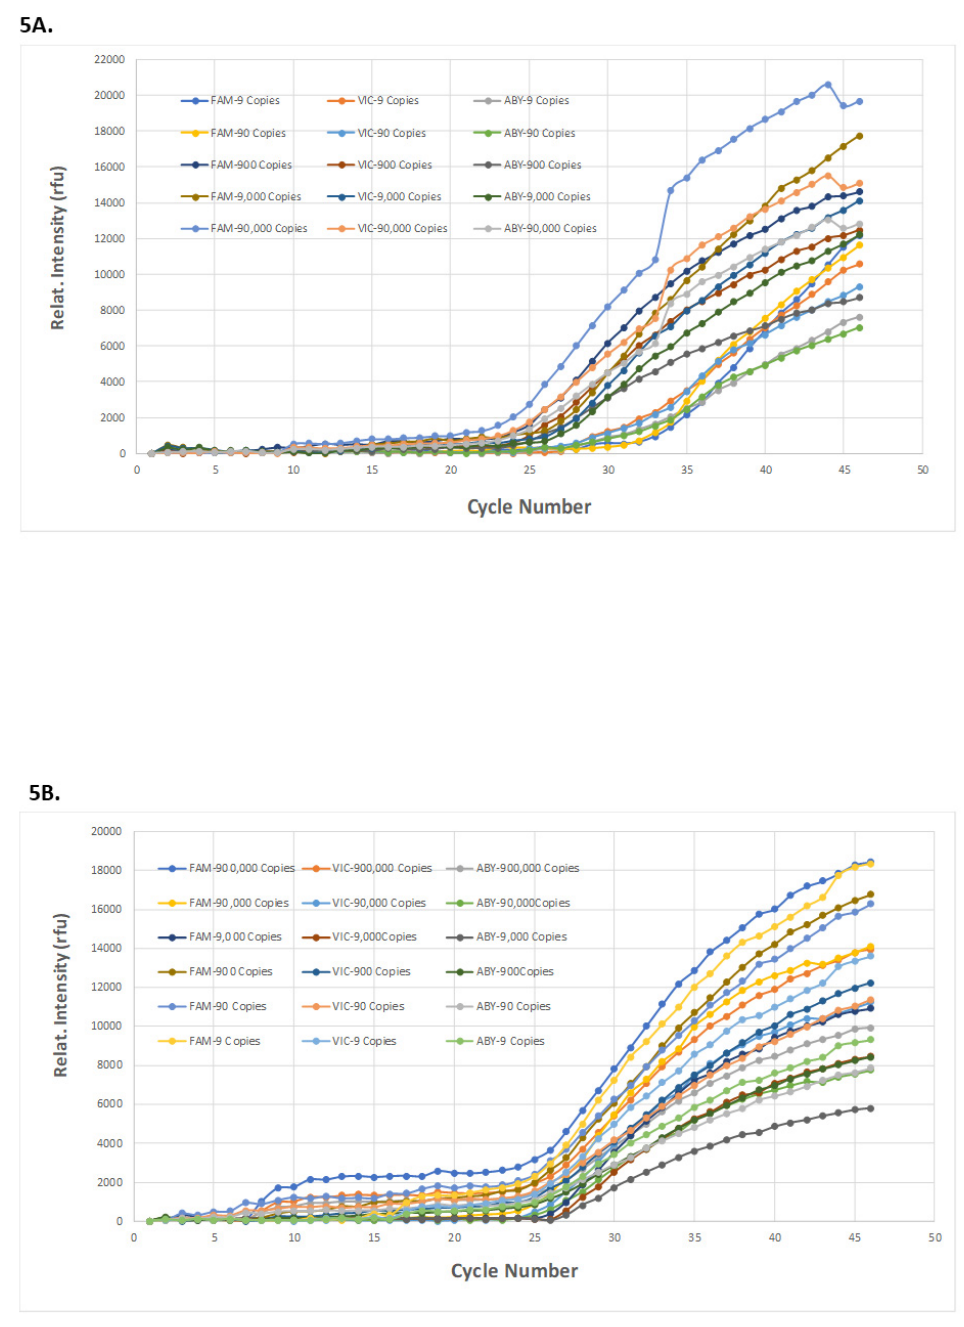
Figure 5. On-cartridge direct detection of SARS-CoV-2 from saliva from sample-in to result-out. Saliva samples spiked with a known copy number of either SARS-CoV-2 plasmid RNA ( 5A ) or γ -irradiated SARS-CoV-2 virions ( 5B ) were loaded in the saliva chamber of the cartridge. The results from the on-cartridge 1-step multiplex RT-qPCR with N1-FAM, N3-ABY, and RNP-VIC primers are shown. The copy number dose-response curves were generated with purified 2019-nCoV N Plasmid-RNA ( 5A ) or γ -irradiated SARS-CoV-2 virions ( 5B ).